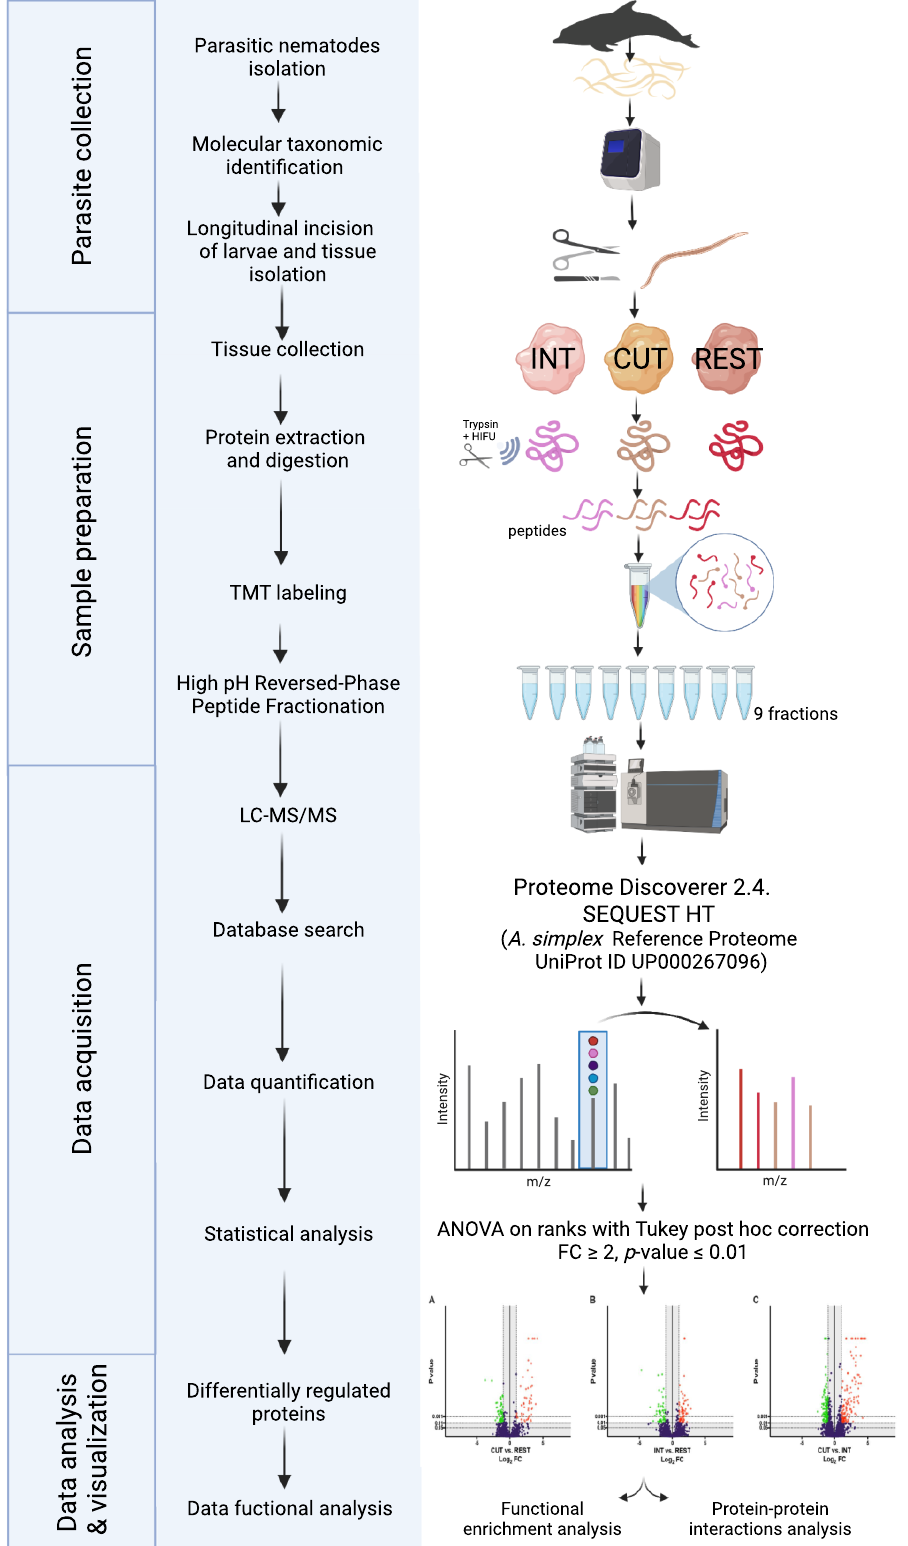
Figure 9. Experimental setup and workflow for comparison of tissue-specific proteomes of Anisakis simplex s. s. larvae at the L4 stage. In total, 12 A. simplex s. s L4 stage larvae were isolated from striped dolphin ( Stenella coeruleoalba ). Samples of the cuticle, intestine, and remaining body of the L4